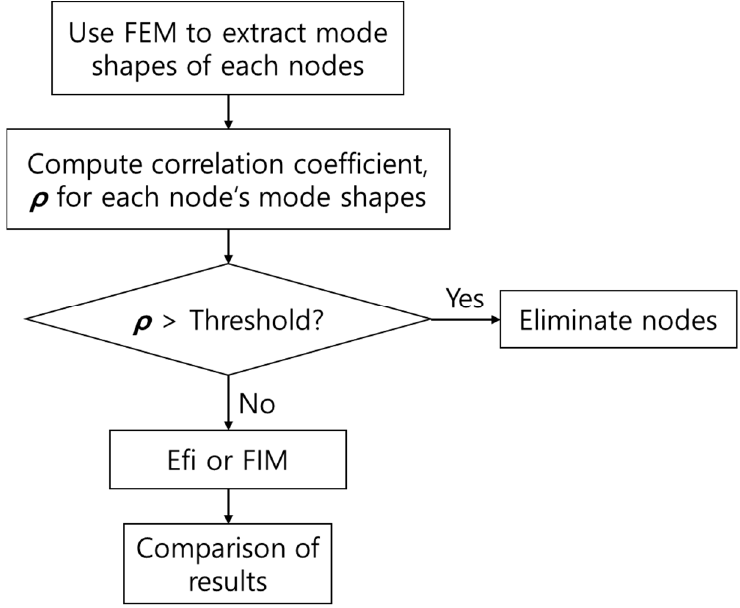
Figure 1. Flowchart. Figure 1.